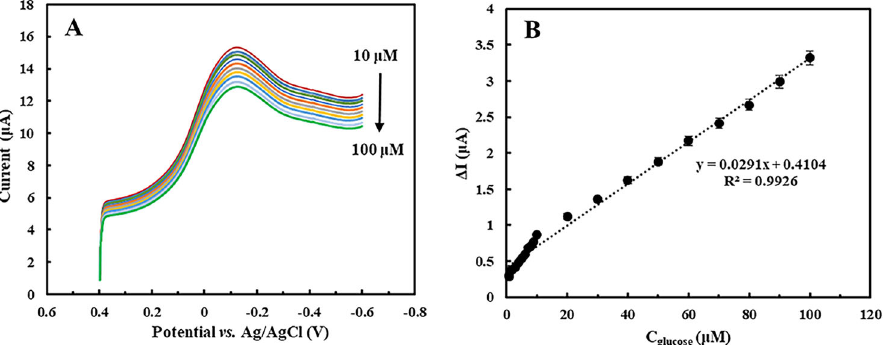
Figure 5. ( A ) Linear sweep voltammograms (LSVs) of the NF/GDH/IL/mPEG-fMWCNTs electrode- modified GCE in the presence of different concentrations of β -D-glucose (10, 20, 30, 40, 50, 60, 70, 80, 90, and 100 µM). ( B ) Linearity of peak current difference ( Δ I) versus glucose concentration. The experiments were performed in PBS (50 mM, pH 7.0) at a potential of − 124 mV versus Ag/AgCl at 25 ± 1 °C.